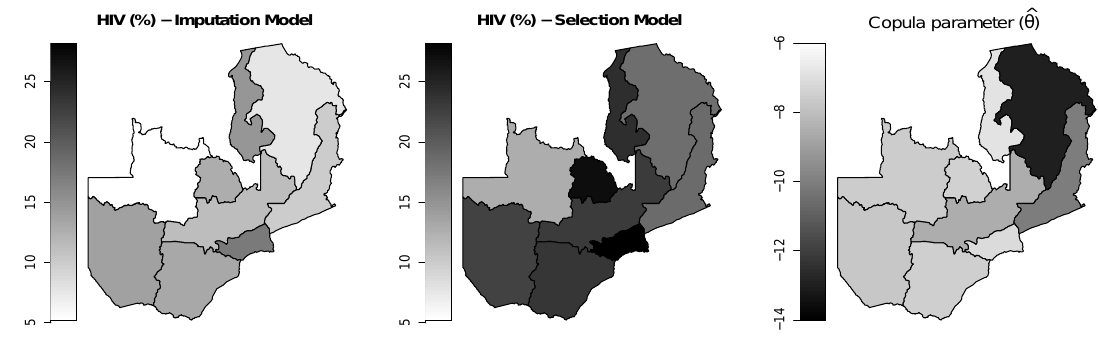
Figure 4: HIV prevalence estimates by region obtained by applying the imputation and sample selection models. The copula parameter plot reports the values of the estimated associations with range (−∞, −1) in the 90 ◦ Joe copula. The higher the ab- solute value, the stronger the association between the selection and outcome